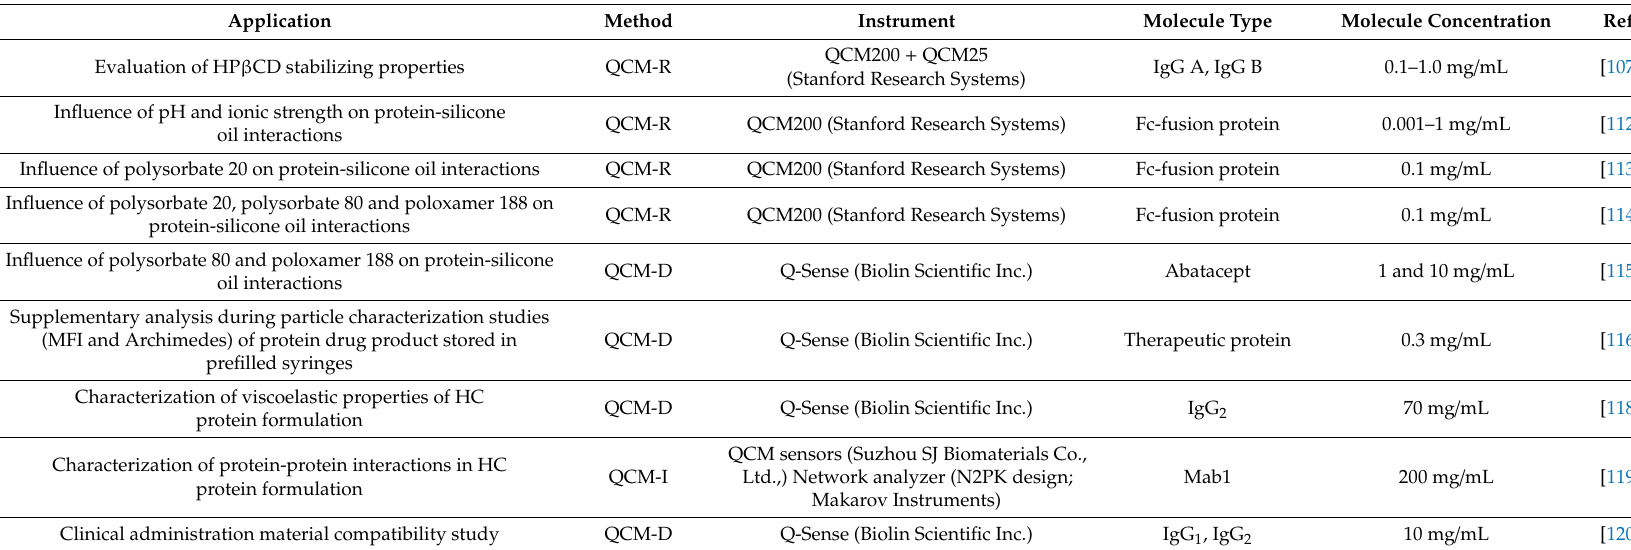
Table 2. Selection of QCM applications in formulation and primary packaging development-related